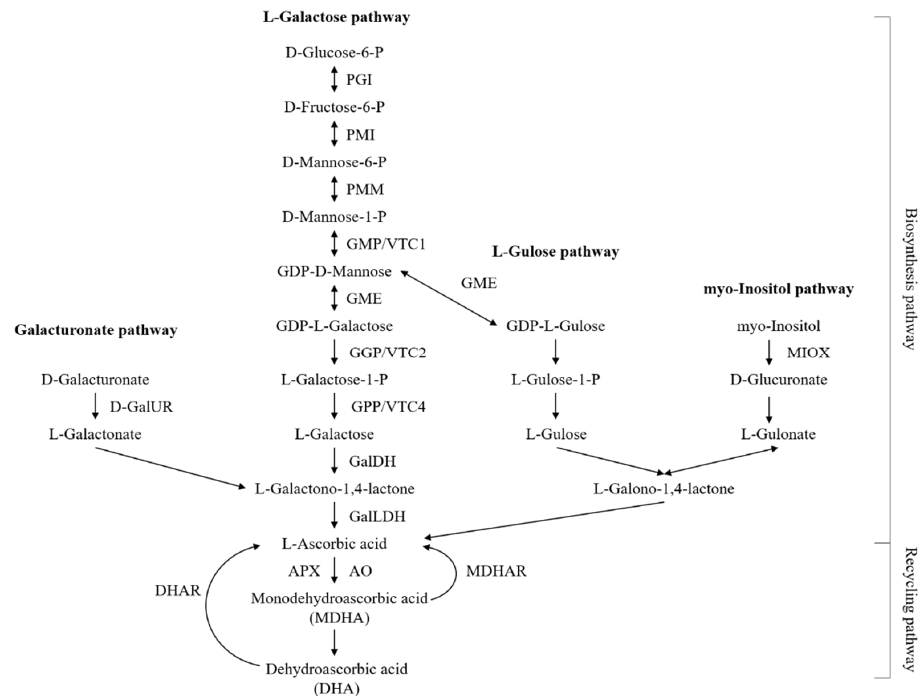
Figure 1. The currently known pathways for AsA biosynthesis and recycling in higher plants. Abbreviations: Phosphoglucoisomerase, PGI; mannose-6-phosphate isomerase, PMI; phosphoman-